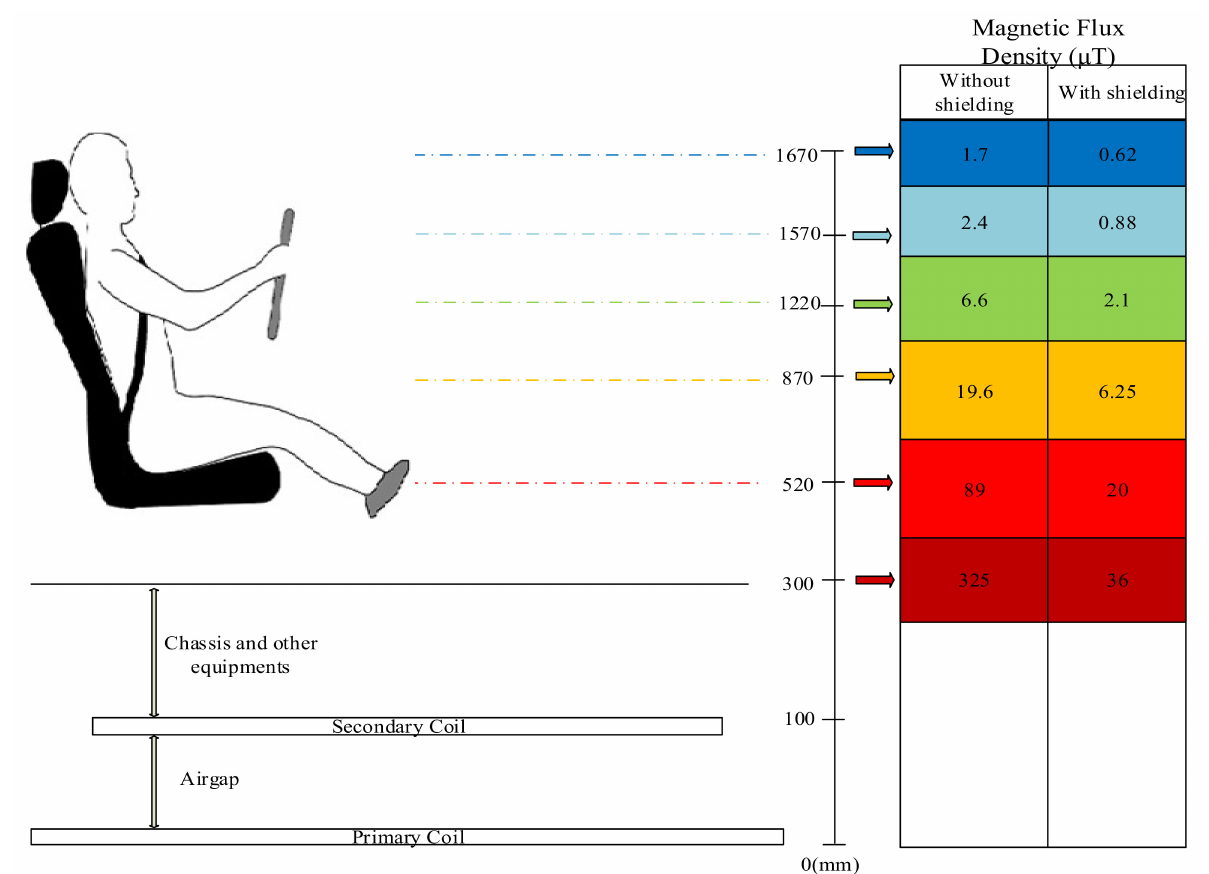
Figure 14. Effect of aluminum shielding on magnetic field density values